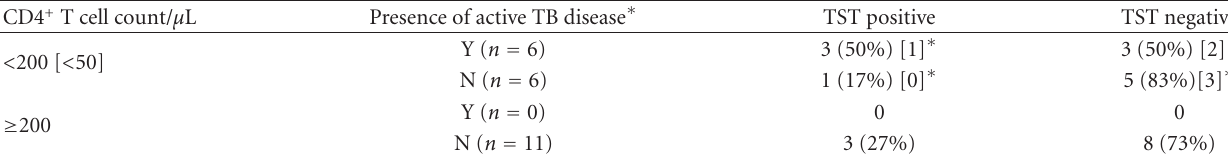
Table 2: Relationship between TST results and CD4 + T cell count.